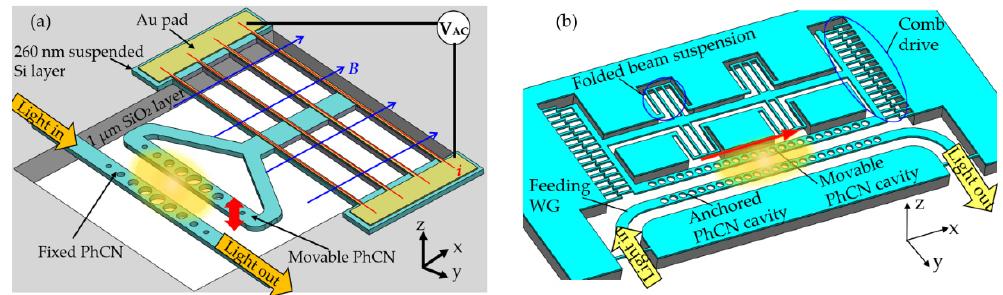
Figure 11. ( a ) Schematic of the magnetic field sensor based on coupled PCN cavity [14]; ( b )schematic of coupled PCN cavity to detect lateral shearing optical force [14]. of coupled PCN cavity to detect lateral shearing optical force [14].